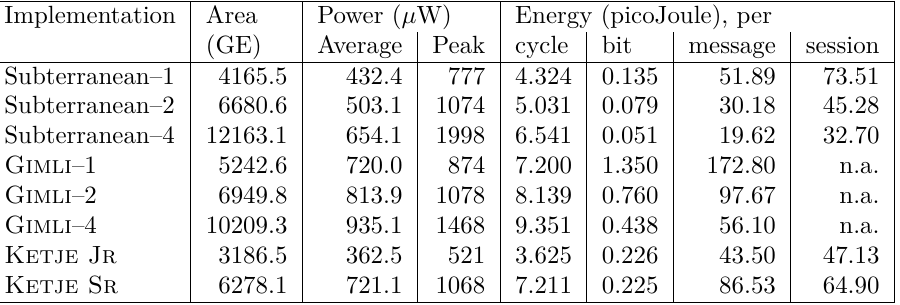
Table 5: Synthesis results for STMicroelectronics 40 nm for frequency 100